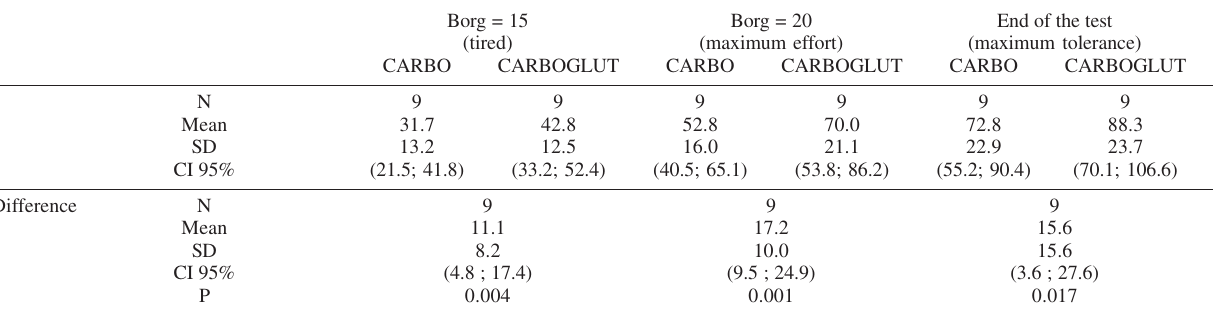
Table 4 – Comparison of the lapse of time to the perception of fatigue verified by the subjective Borg scale at three moments of exercise in relation to the soccer players with supplementation of carbohydrate (CARBO) and the mixture of carbohydrate and peptide glutamine